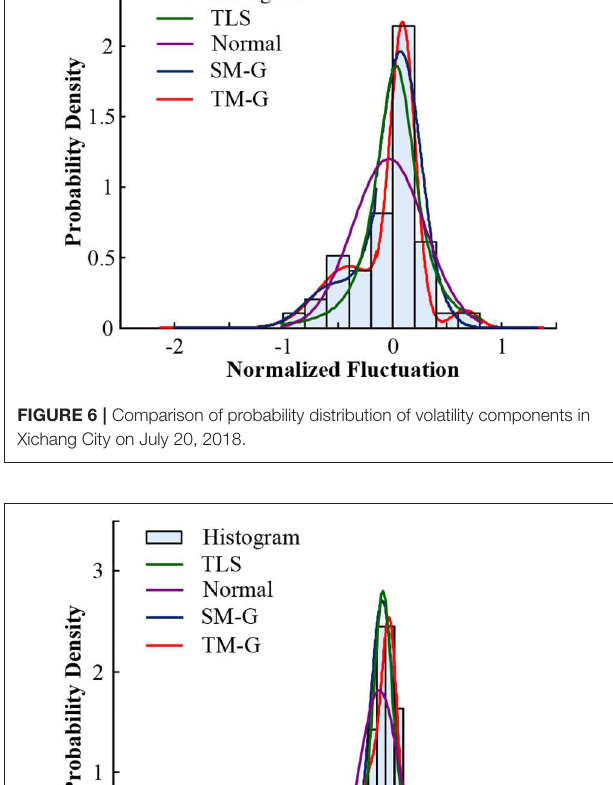
TABLE 2 | Index value of data fitting effect in Xichang City on July 20, 2018. Distribution Function